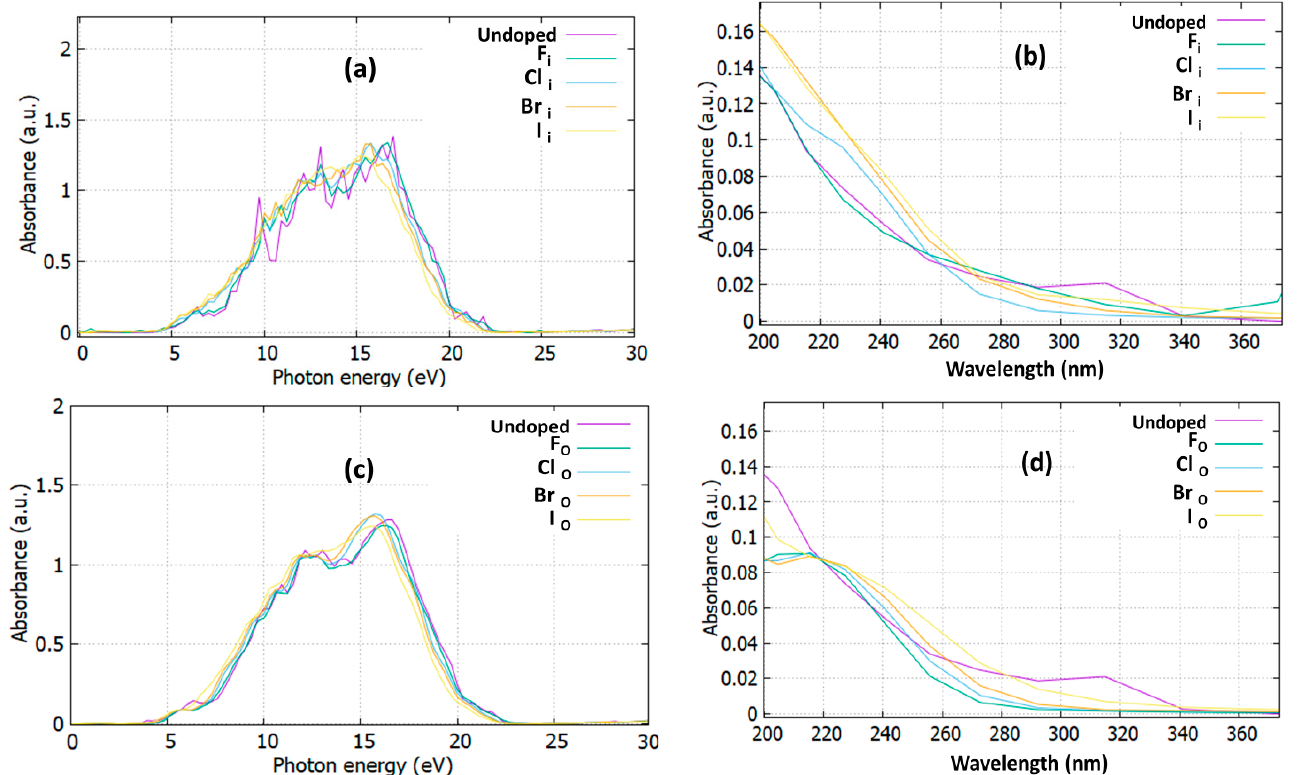
Figure 7. The absorption for ( a ) interstitially doped SnO 2 for all the energy spectrum, ( b ) interstitially doped SnO 2 as a function of the wavelength, ( c ) substitutionally doped SnO 2 for all the energy spectrum, ( d ) substitutionally doped SnO 2 as a function of the wavelength.